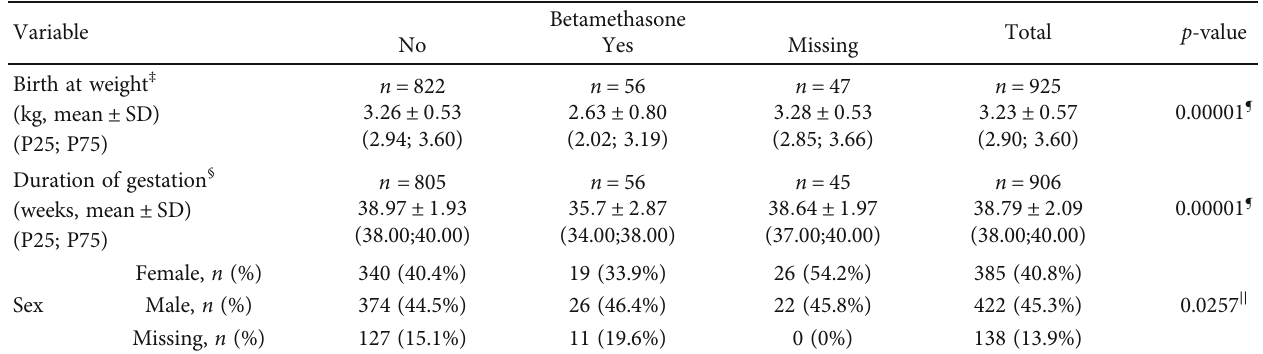
Table 2: Variable distribution depending on betamethasone treatment.